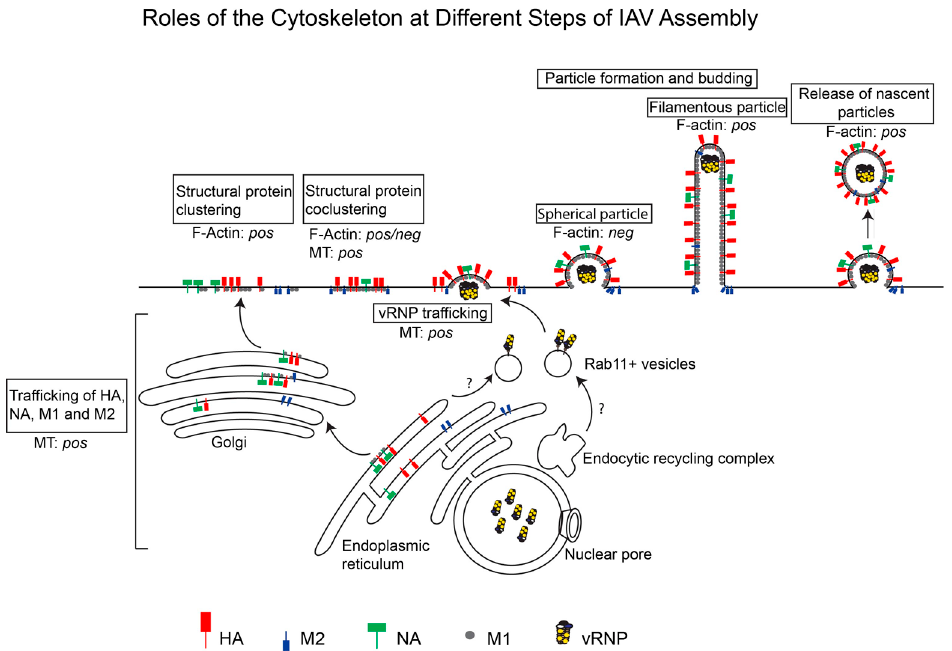
Figure 1. Roles of the actin cytoskeleton and microtubules at different steps of IAV Assembly. IAV assembly is initiated at the plasma membrane after the arrival of three transmembrane proteins, HA, NA, and M2, and the cytoplasmic protein M1 through the cytoplasm. Clustering of these viral proteins drives assembly of the virus particle, which could have a spherical or filamentous morphology. vRNPs are transported across the cytoplasm on Rab11+ vesicles and are incorporated into the assembling virus particle. Whether the actin cytoskeleton and/or microtubules (MT) promote ( pos ) or suppress ( neg ) individual IAV assembly steps is